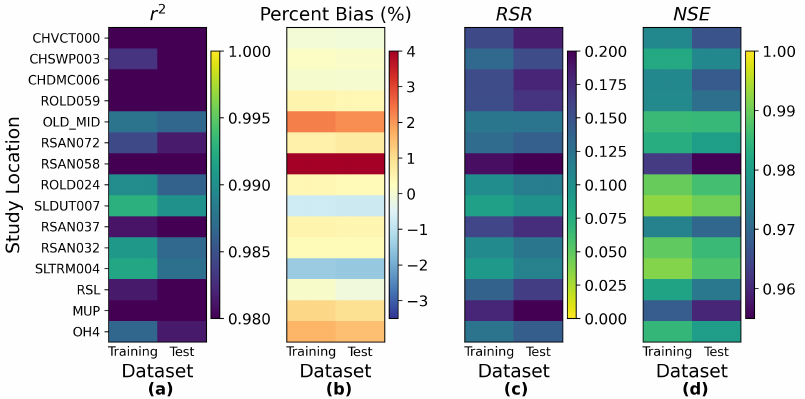
Figure A18. Model (grouped MLP) performance measured by ( a ) r 2 , ( b ) Percent Bias, ( c ) RSR, and ( d ) NSE on training and test set at the study locations belonging to the interior Delta group.